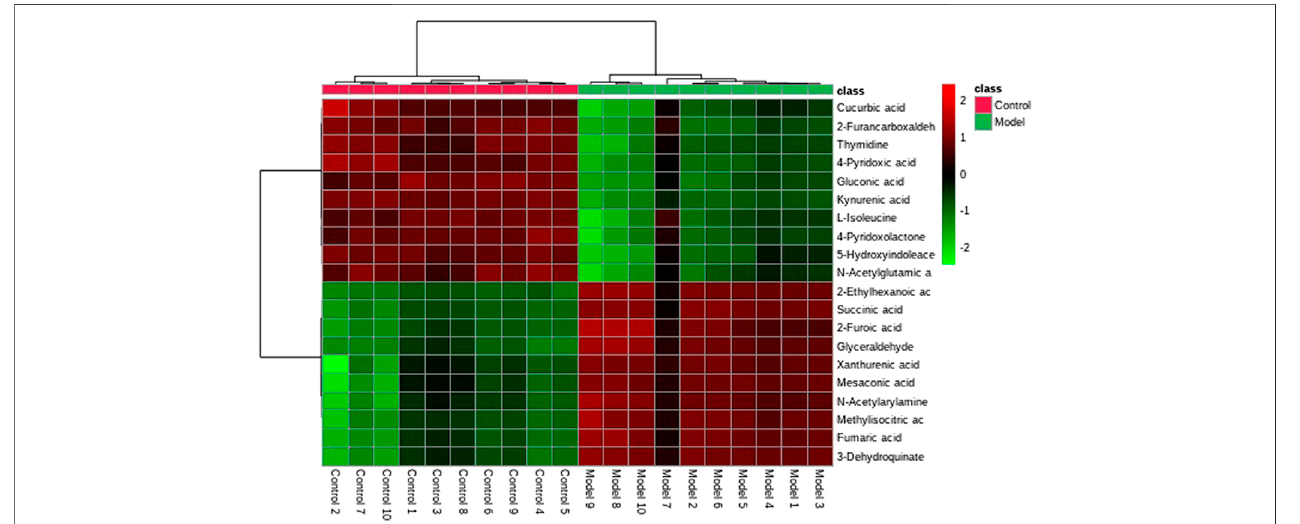
FIGURE 4 | Hierarchical clustering of the differential metabolites in the control and model